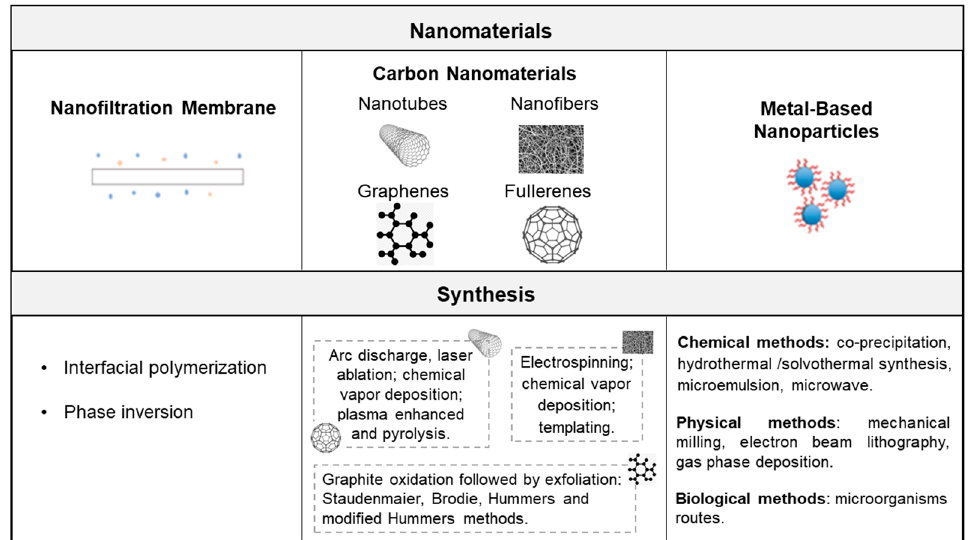
Figure 2. Schematic illustration of the synthesis of nanomaterials for application in the remediation of emerging pollutants.